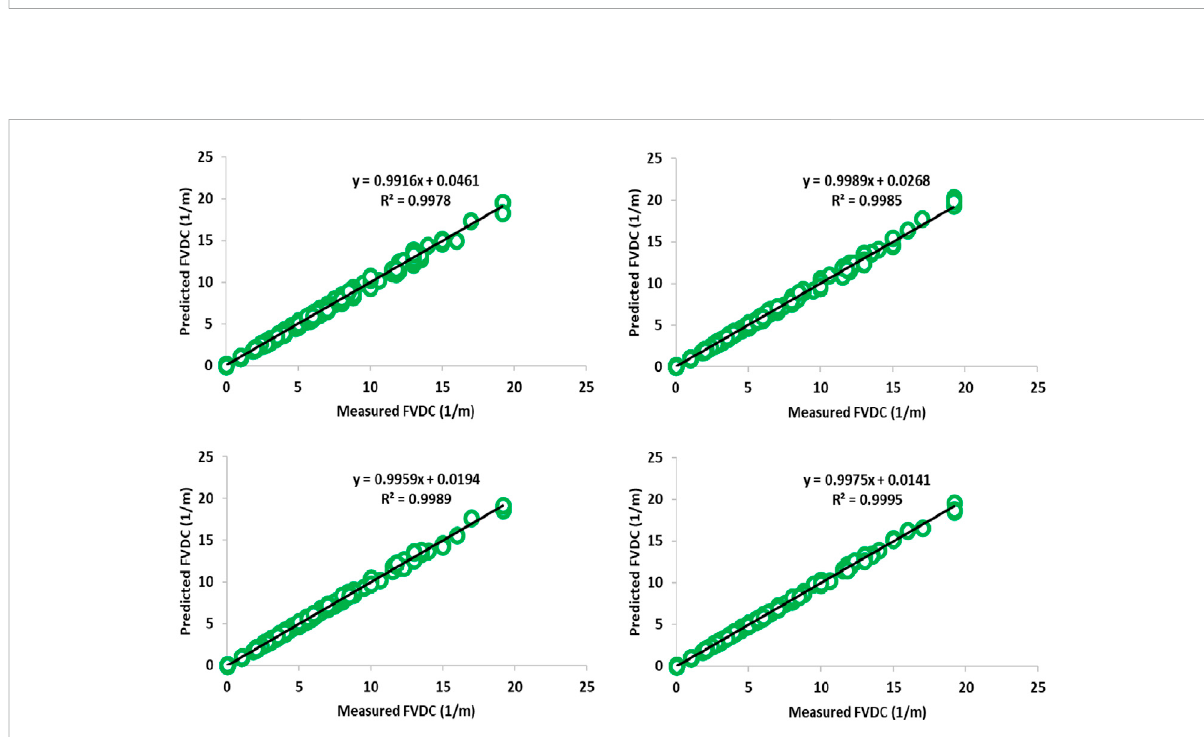
FIGURE 13 llustration of cross plot for training subset (70% ~ 2049 data point) based on four roboust hybrid machine learning LSSVM-PSO, LSSVM-GA, MLP-PSO and MLP-GA based on dataset of well #W1.